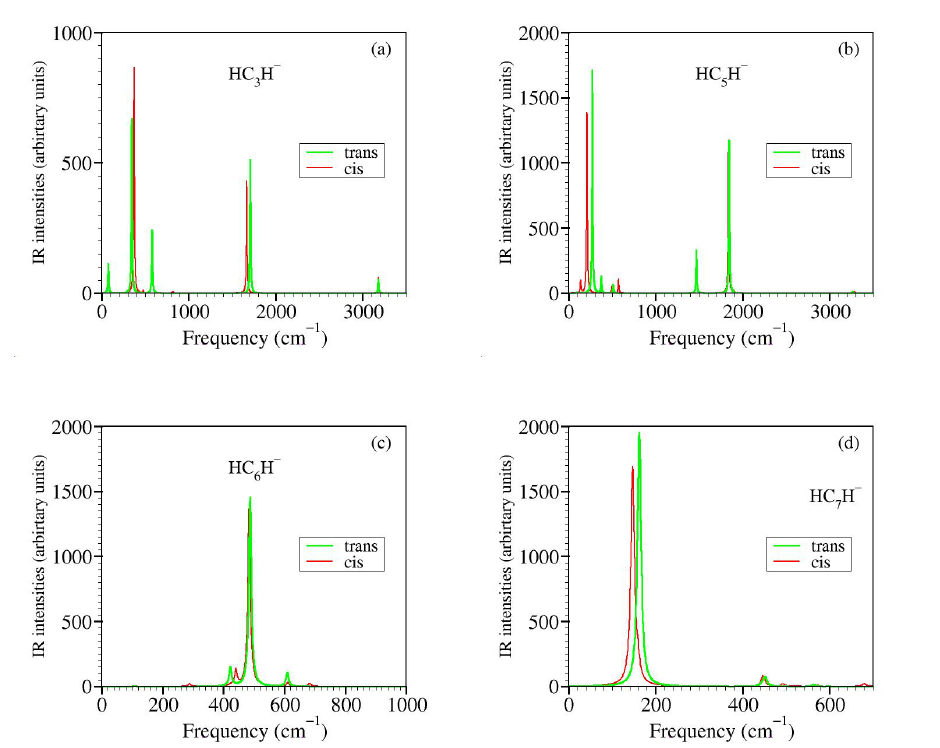
Figure A2. Differences between infrared spectra of cis and trans HC n H – anion conformers visible here make it possible to experimentally differentiate between them. Curves obtained by using a Lorentzian convolution of halfwidth of 5cm − 1 . ( a ) HC 3 H − ; ( b ) HC 5 H − ; ( c ) HC 6 H − ; ( d ) HC 7 H −